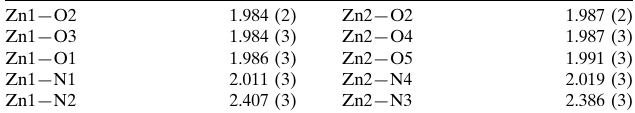
cations adopt Hydrogen-bond geometry (A˚ , (cid:3) N trigonal-bipyramidal geometries with one distorted ZnO 3 2 N atom in a axial site and one N atom in an equatorial site, arising from coordination by the N , N , N , N , O , O , O -hepta- dentate ligand and a bridging acetate ion. In the crystal, intermolecular O—H (cid:2) (cid:2) (cid:2) O hydrogen bonds link the compo- nent units into a three-dimensional network. Two short C—